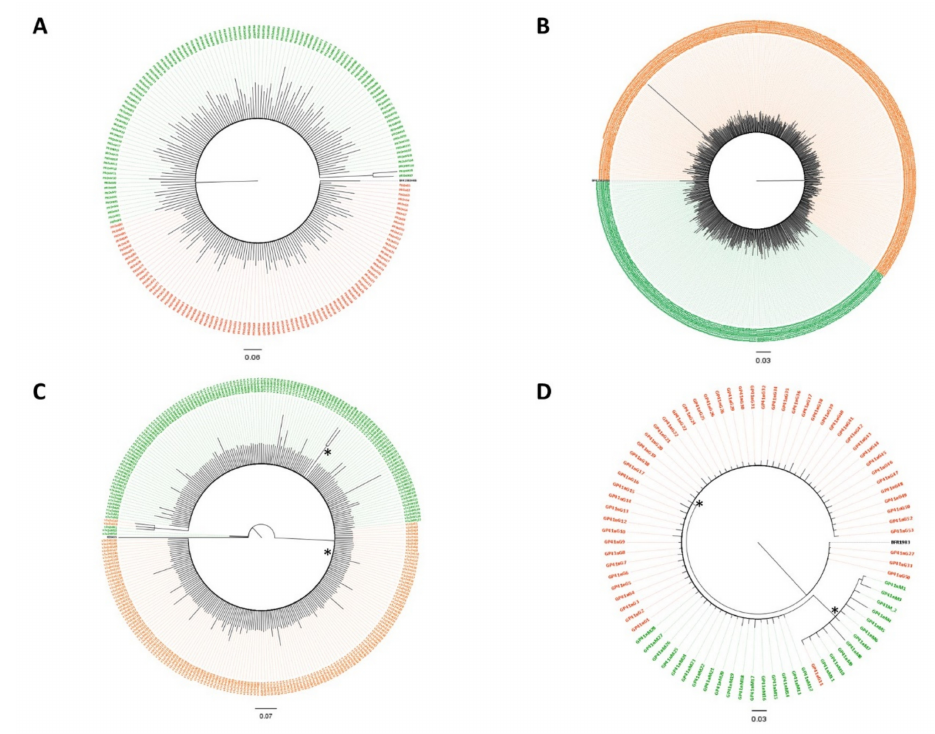
Figure 1. Bayesian trees for quasispecies of the human immunodeficiency virus (HIV) protease ( A ), RT ( B ), V1V2 ( C ) and gp41 ( D ) regions from the male (G, orange color) and female (M, green color) partners of the couple based on the analyses of whole-blood samples obtained before the start of therapy. Significantly different clusters are indicated with an asterisk.